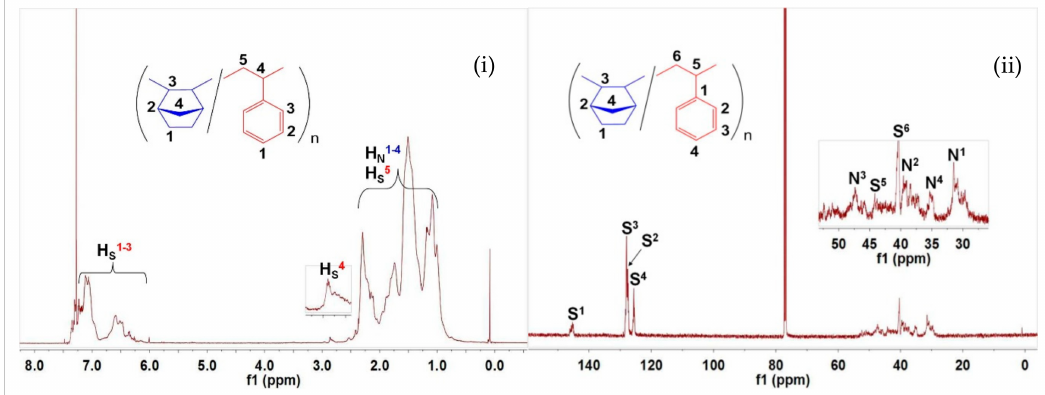
Figure 2. 1 H NMR ( i ) and 13 C NMR ( ii ) spectra of N / S copolymer obtained by Run 15 (CDCl 3 , rt, 500